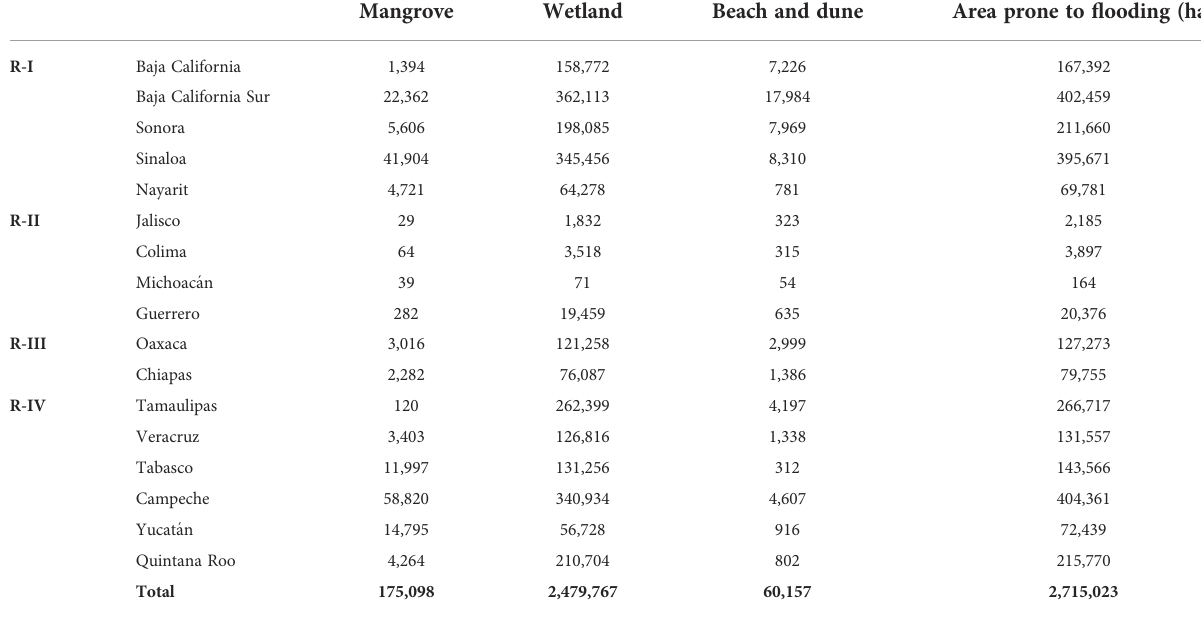
TABLE 2 Total area and area by ecosystem prone to fl ooding for the Mexican coast.